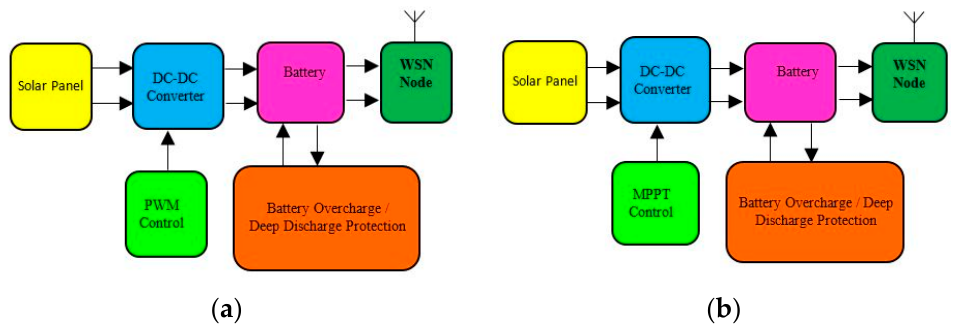
3 of 18 Figure 1. Block diagram of Solar Energy Harvesting Wireless Sensor Network Node (SEH-WSN). The measured or sensed data is sent to the nearby network node wirelessly, in the form of data packets using the transmitter unit. The information is sent to the USB gateway node via cluster head nodes [6] from the end nodes. Finally, the user can remotely monitor & control the application process e.g., temperature monitoring, control of an industrial boiler plant, volcano monitoring, glacier monitoring, forest monitoring, battlefield monitoring applications, air conditioner cooling system control, traffic light management in a smart city. 3. Solar Energy Harvesting System A basic solar energy harvesting system consists of a Solar Panel, DC-DC converter, rechargeable battery, a battery charge protection circuit called battery management system (BMS) and DC-DC converter control unit. Generally, there are two types of DC-DC converter control methods: (1) Pulse width modulation (PWM) control and (2) Maximum power point tracking (MPPT) control. The Figure 2a shows a block diagram of a pulse width modulation (PWM) controlled DC-DC buck converter. Similarly, the Figure 2b shows the block diagram of Perturb & Observation (P&O) maximum power point tracking (MPPT) controlled solar energy harvester (SEH) system. In Figure 2b, the SEH system consists of a solar panel, a DC-DC buck converter, a rechargeable battery, a maximum power point (MPPT) controller, and a WSN sensor node connected as a DC load. The ambient solar light energy is harvested using the solar panel and converted into the electrical energy. The DC-DC Buck converter steps down and regulates the magnitude of this harvested voltage, and supplied to the rechargeable battery. The MPPT controller tracks the voltage and current from the solar panel and adjusts the duty cycle accordingly for the MOSFET of DC-DC Buck converter [7]. Finally, the battery voltage is utilized to operate the wireless sensor node. The WSN performs the function of sensing, computation, and communication with other similar characteristics nodes. Thus, autonomous operation of monitoring and control of any physical phenomenon such as temperature,